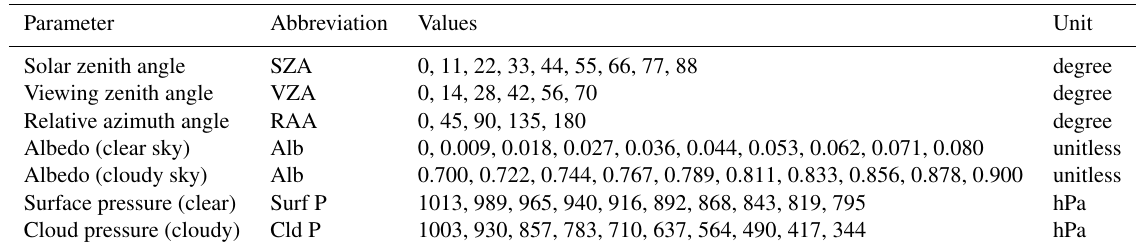
Table 1. The values used for the five input parameters to the AMF TOMRAD lookup table in the sensitivity tests. Albedo (Alb) and surface pressure have different sets of values when the sensitivity test is looking at clear sky and cloudy sky scenarios. For cloudy scenes, the cloud pressure (Cld P) is used as the surface pressure (Surf